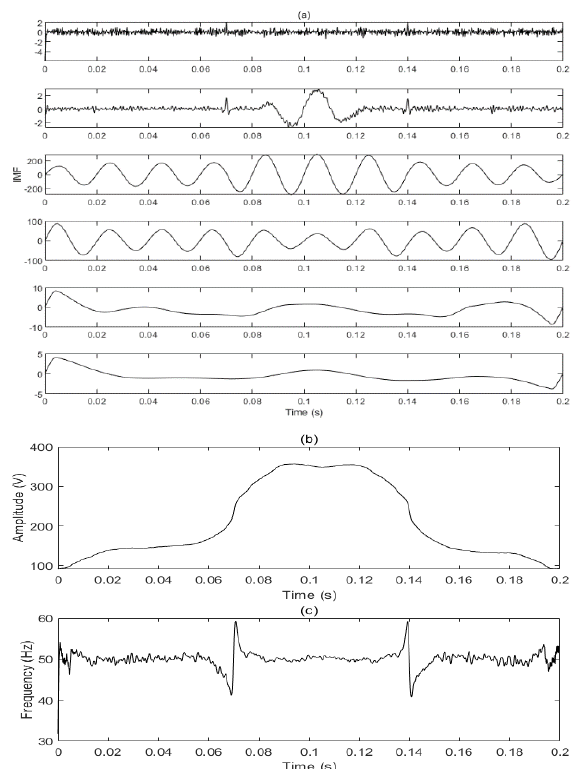
Figure 15. Voltage swell IMF components ( a ), amplitude ( b ), and frequency ( c ).